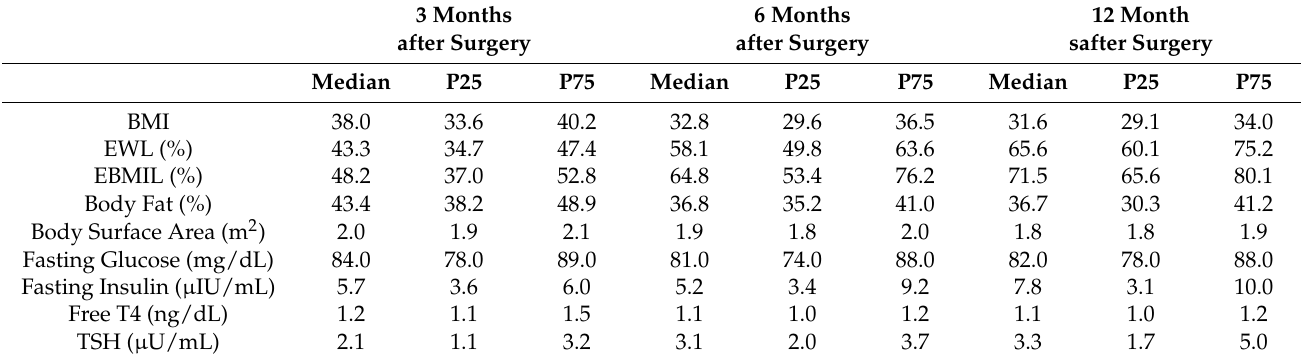
Table 2. Clinical and analytical parameters of the morbidly obese hypothyroid patients (median, interquartile ranges) three, six, and twelve months after surgery.